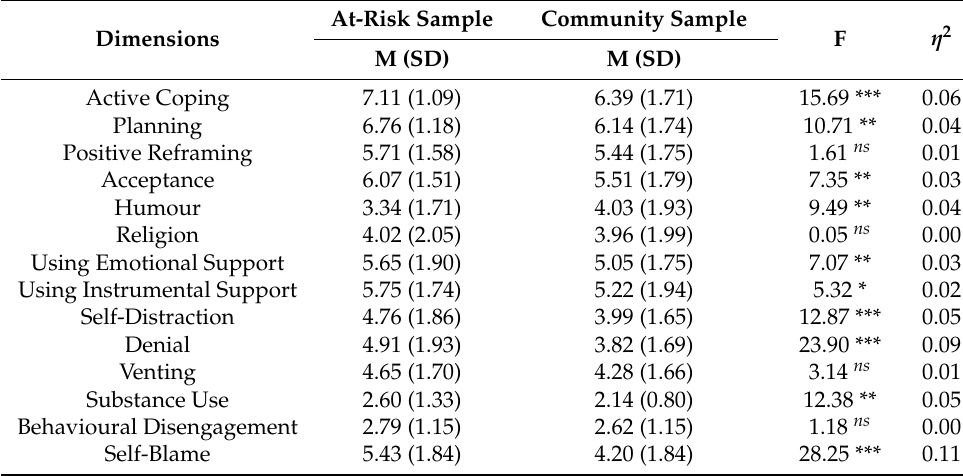
Table 7. Brief COPE comparison among community and risk